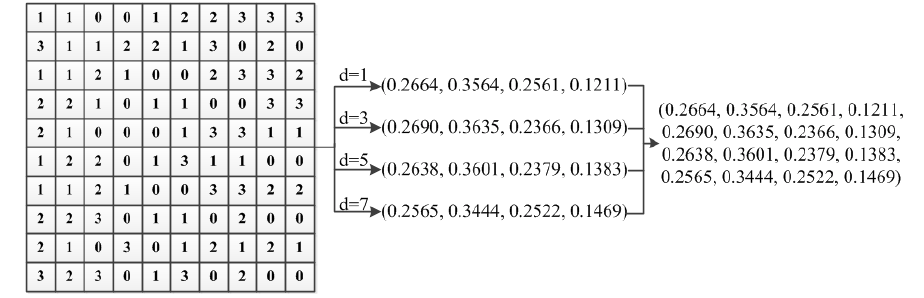
Figure 4. Example of multi-distance color fuzzy correlogram vector computation.